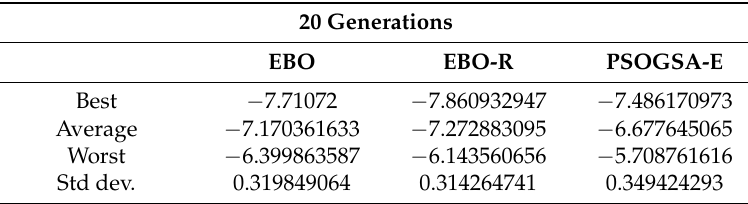
Table 1. Statistics for different algorithm (20 generations).